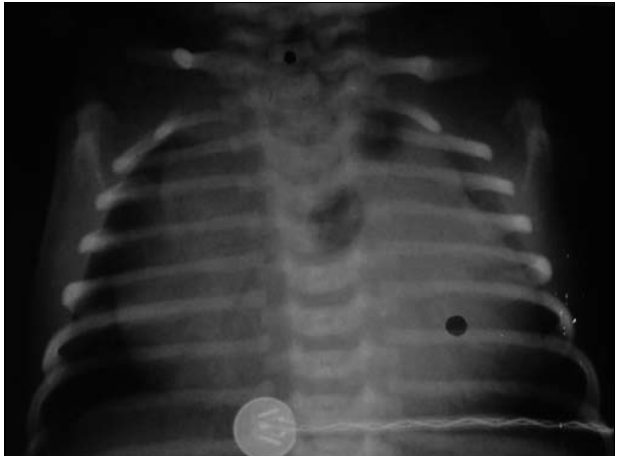
Fig. 1. Frontal radiograph of the patient’s chest shows massive global